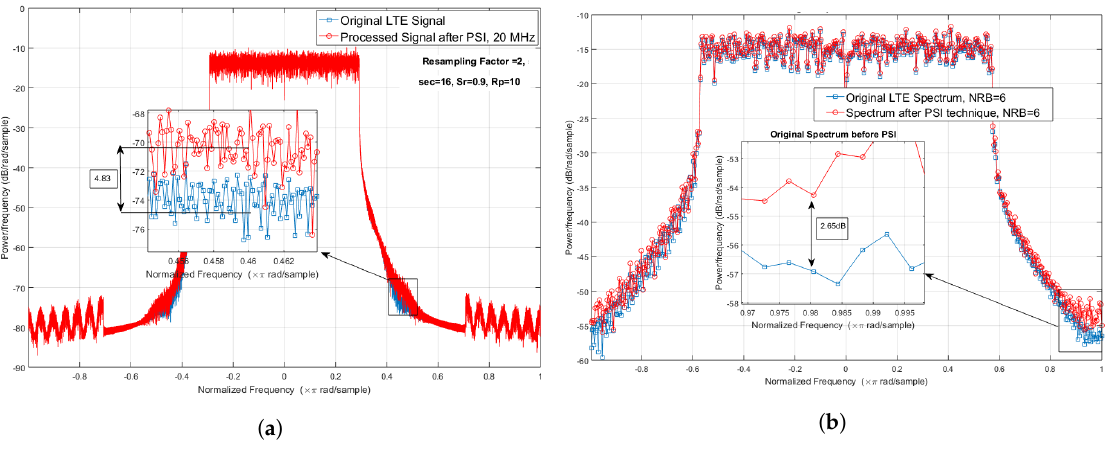
Figure 12. ( a ) Signal spectrum before and after PSI technique, when NRB = 100 [24]. ( b ) Signal spectrum before and after PSI technique for LTE when NRB = 6.